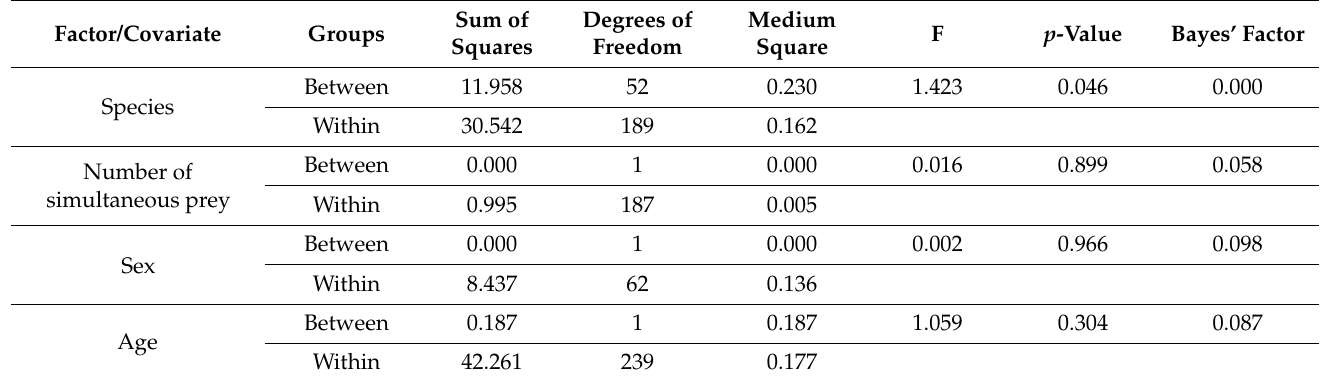
Table 2. Summary of results from Bayesian ANOVA to detect differences in mean probability of success in prey escape across prey-related factors and covariates.